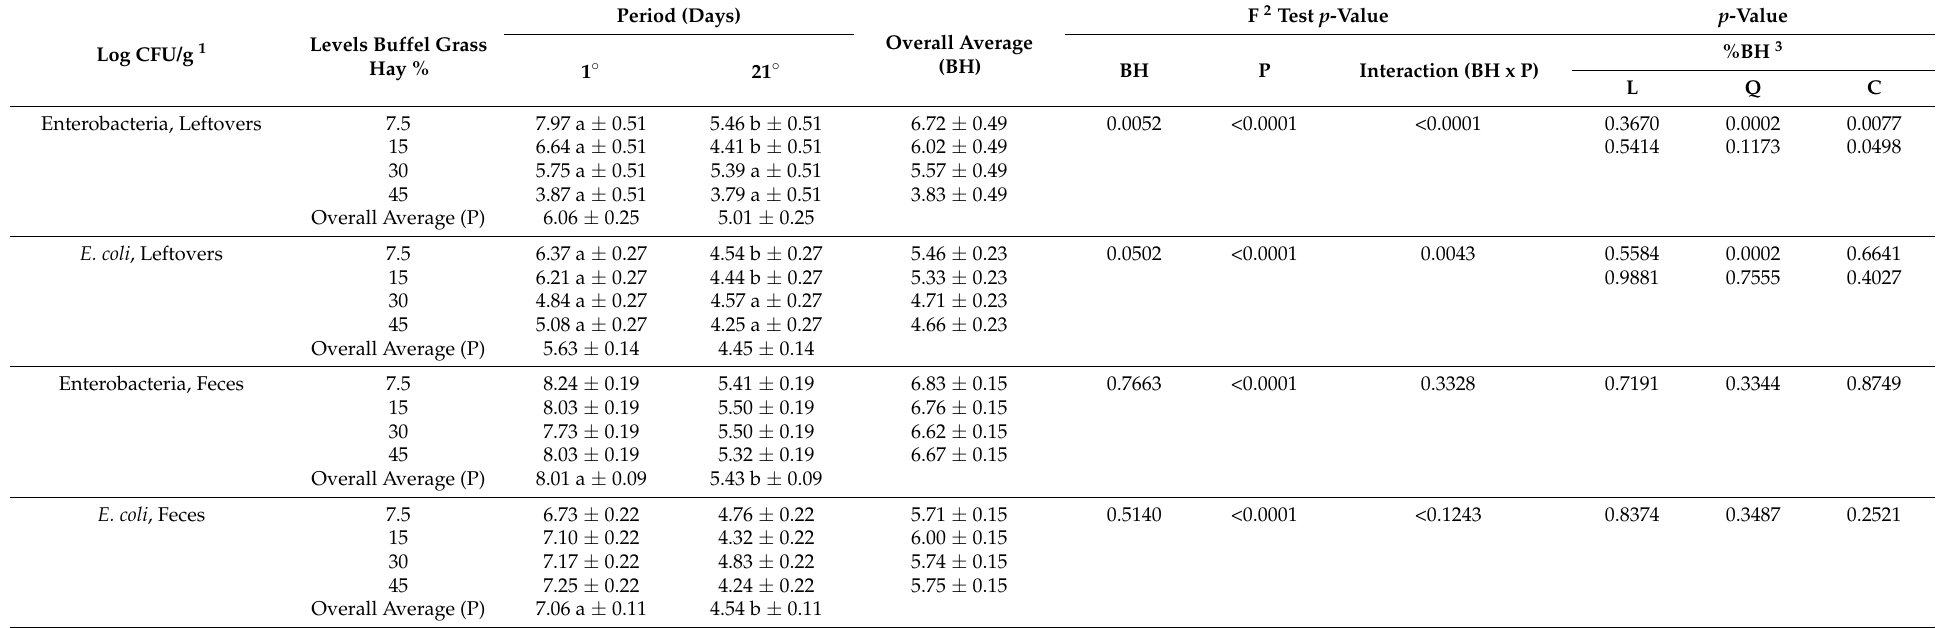
Table 3. Bacteria count in leftovers and feces of sheep fed levels of buffel grass hay and cactus